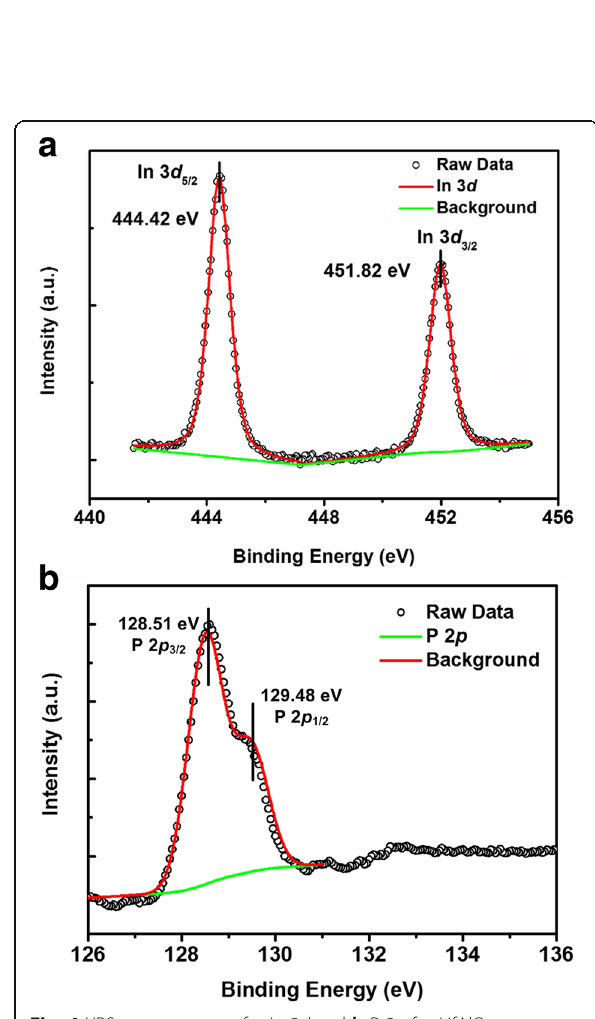
Fig. 4 XPS narrow scans of a In 3 d and b P 2 p for HfAlO (4 nm)/InP